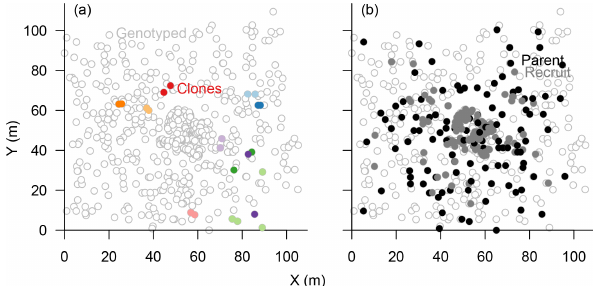
Figure 3. Map of genotyped Larix gmelinii individuals at site TY04VI; individuals sharing the same genotype (clones) are marked by filled points of the same colour in (a) , and local recruits are marked by filled bright circles, whereas parents by filled black circles, in (b)